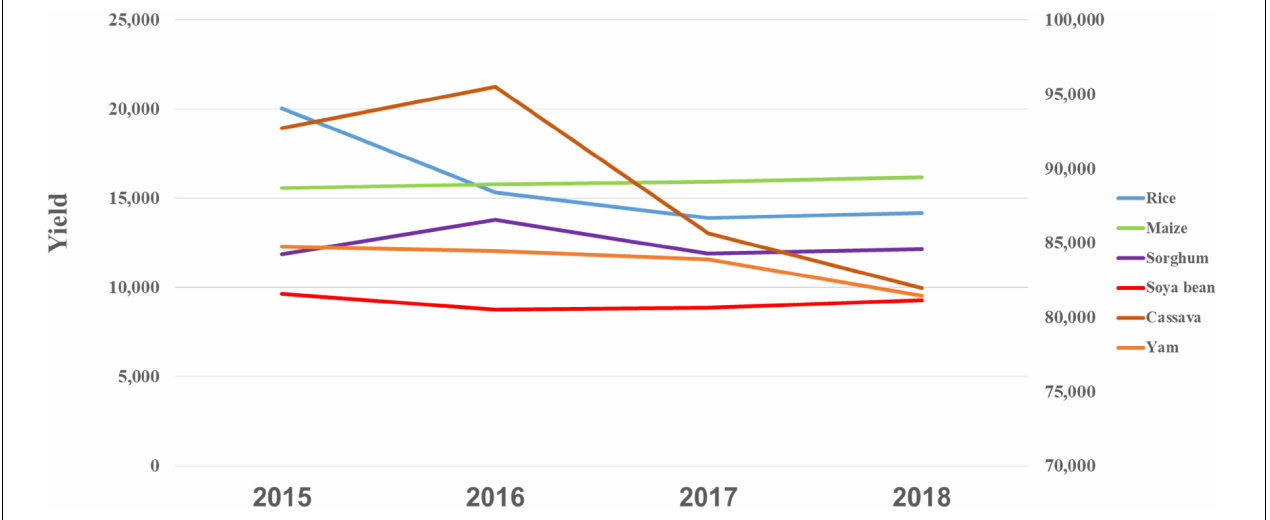
FIGURE 1 | Crop yield from 2015 to 2018